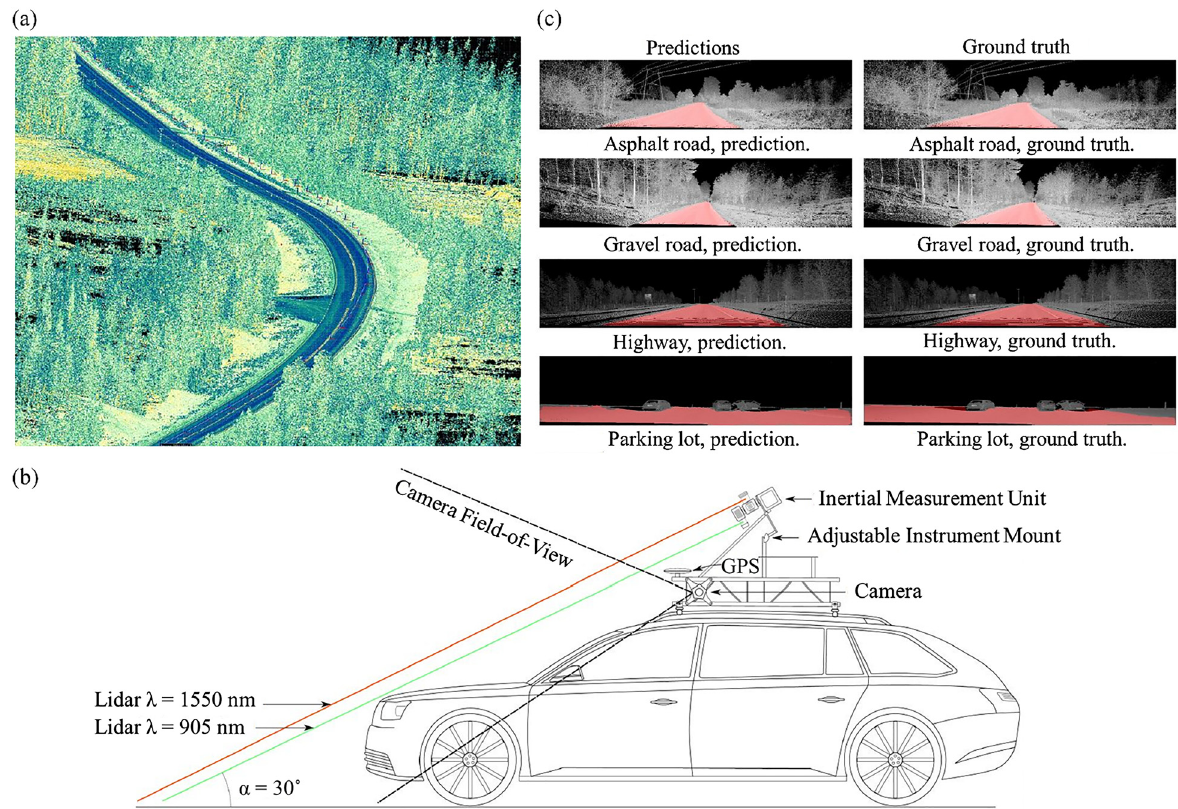
Figure 3: Multispectral LIDAR system applied for autonomous driving. (a) A point cloud captured by 1550 and 905 nm line-scanning LIDAR systems RIEGL VUX-1HA and RIEGL miniVUX-1UAV, respectively. (b) Schematic of LIDAR measurement setup, showing a multispectral LIDAR system, visible camera, and GPS mounted on top of the vehicle for data collection. (c) Road area prediction examples in comparison with the ground truth. (a) – (c) are adapted from the study by Taher [18] with permission. Copyright Josef Taher, Finnish Geospatial Research Institute